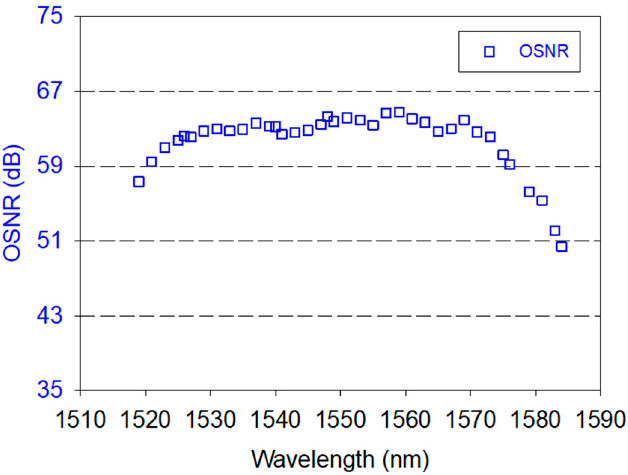
Figure 5. Measured OSNR of each wavelength in the tuning range of 1519.0 to1584.0 nm.